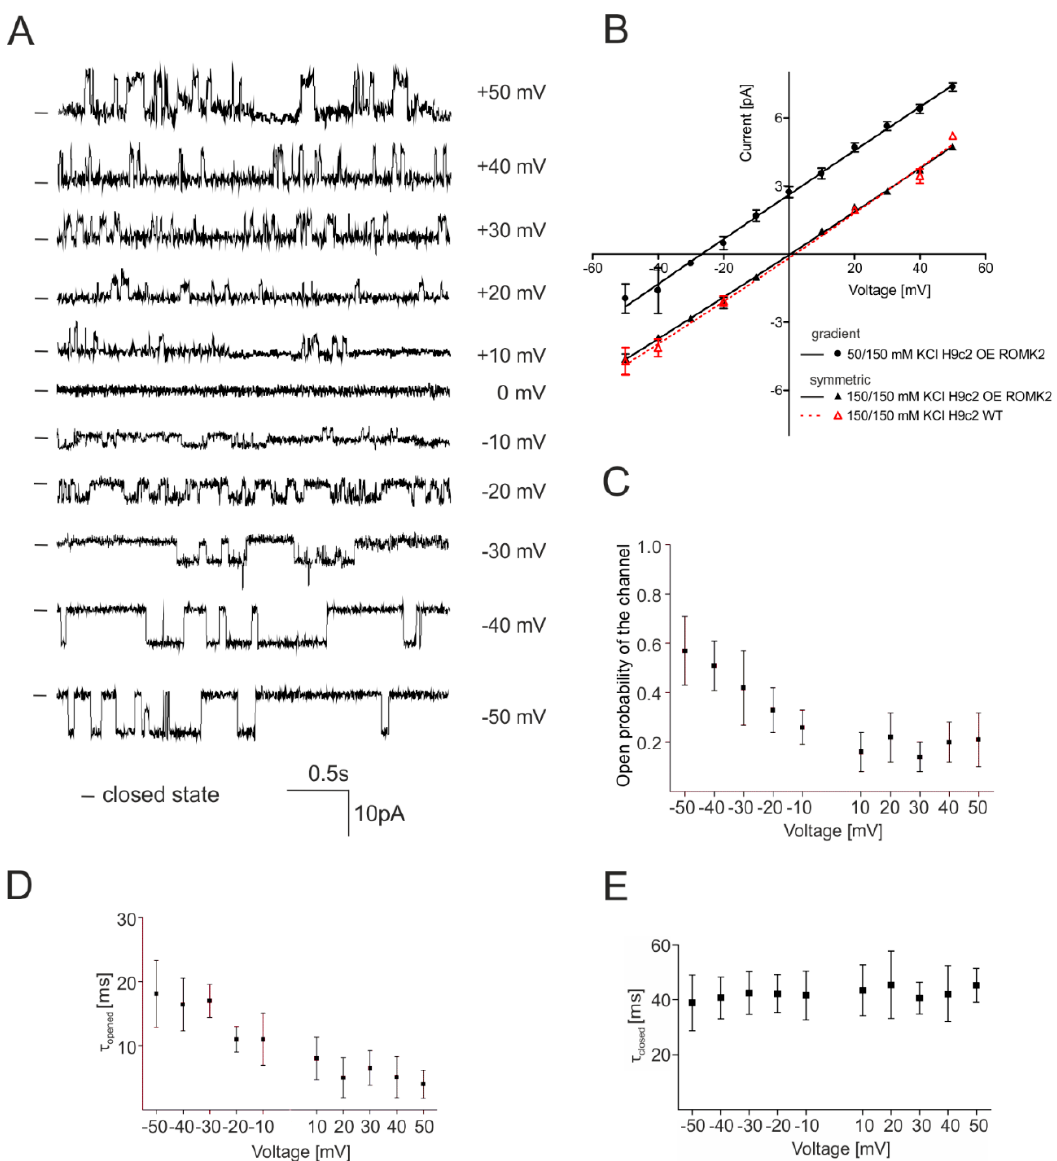
Figure 2. The biophysical properties of mitoK ATP from the inner mitochondrial membrane of the H9c2 OE ROMK2 and H9c2 WT cells using the patch-clamp technique. ( A ) Single-channel recordings in a symmetrical 150 / 150 mM KCl solution at di ff erent voltages of the mitoK ATP channel from the mitochondria of the H9c2 OE ROMK2 cells. ( B ) Current–voltage characteristics of single-channel events in symmetrical 150 / 150 (solid lines, filled triangles) and asymmetrical 50 / 150 mM KCl (solid lines, filled circles) of mitoK ATP from the H9c2 OE ROMK2 cells and in symmetrical 150 / 150 mM KCl of mitoK ATP from the H9c2 WT cells (dashed line, hollowed triangles). ( C ) Channel open probability (P o ) at di ff erent potentials of the channels from the H9c2 OE ROMK2 cells. ( D ) Voltage dependence of the mean channel open time in the symmetrical 150 / 150 mM KCl solution. ( E ) Voltage dependence of the closed dwell time of the channel from the H9c2 OE ROMK2 cells in a symmetrical 150 / 150 mM KCl solution. The biophysical properties of the channels were calculated based on individual mitochondrial isolations from independent cell cultures ( n = 8 in the case of the H9c2 OE ROMK2 cells). Each mitochondrial isolation was performed from 2–3 mln cells. The results are presented as the means ± SD.